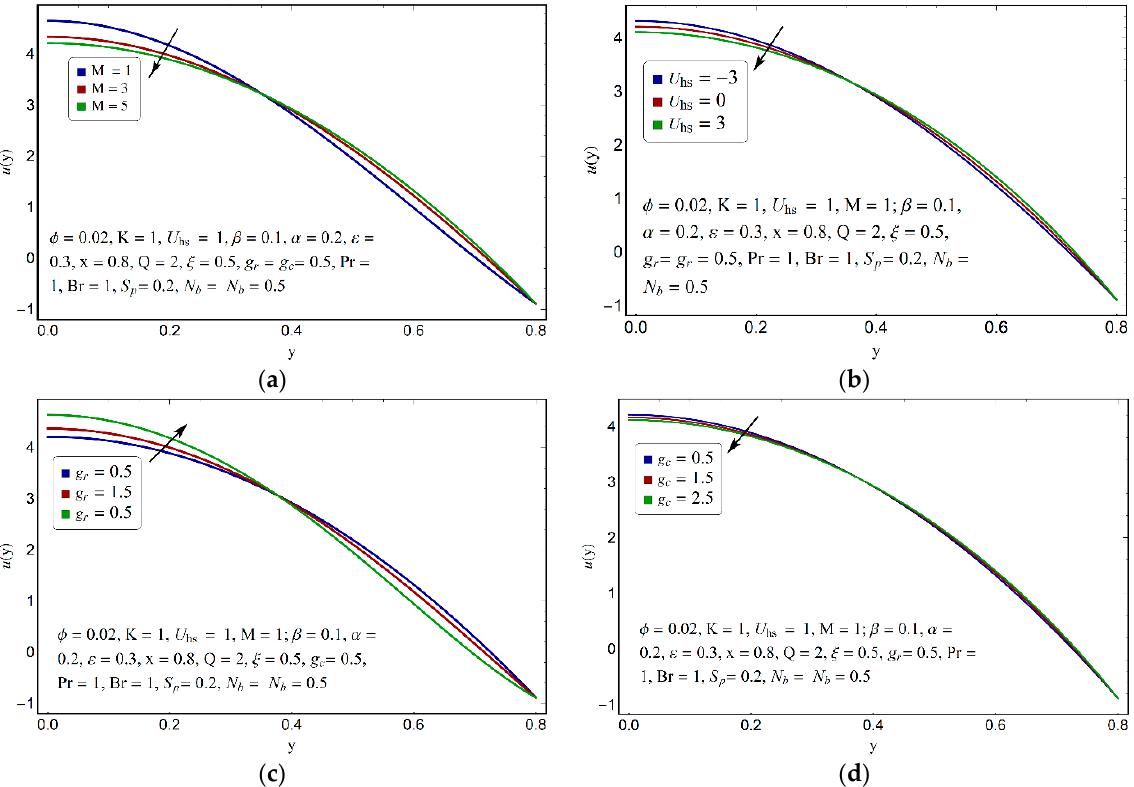
Figure 3. The axial velocity distribution u ( y ) versus y for varying ( a ) magnetic field M ( b ) Helmholtz-Smoluchowski velocity U hs , ( c ) Grashof number g r , and ( d ) solutal Grashof number g c .